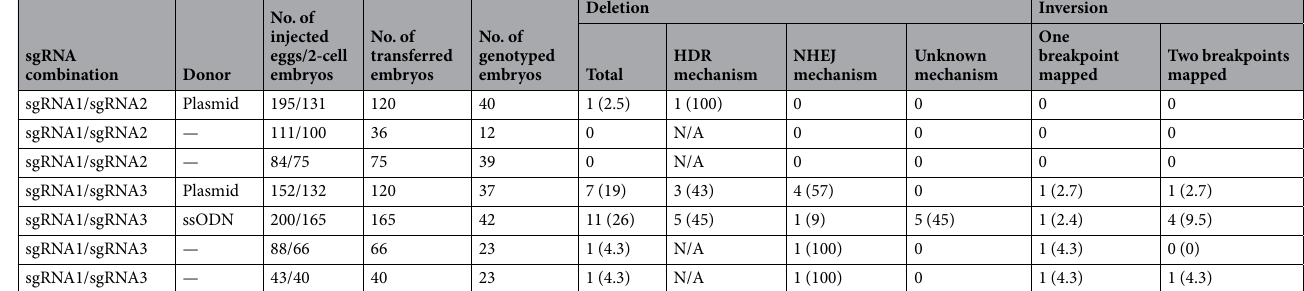
Table 1. Summary of microinjection-based generation of mutant mice. The numbers in parentheses are Total, One, and Two breakpoints mapped representing the percentages calculated from the number of mutants relative to the number of genotyped embryos. The numbers in parentheses in HDR mechanism, NHEJ mechanism, or Unknown mechanism represent the percentages calculated from the number of mutants relative to the number of total deletions. The dash means that no donor was used; N/A: not